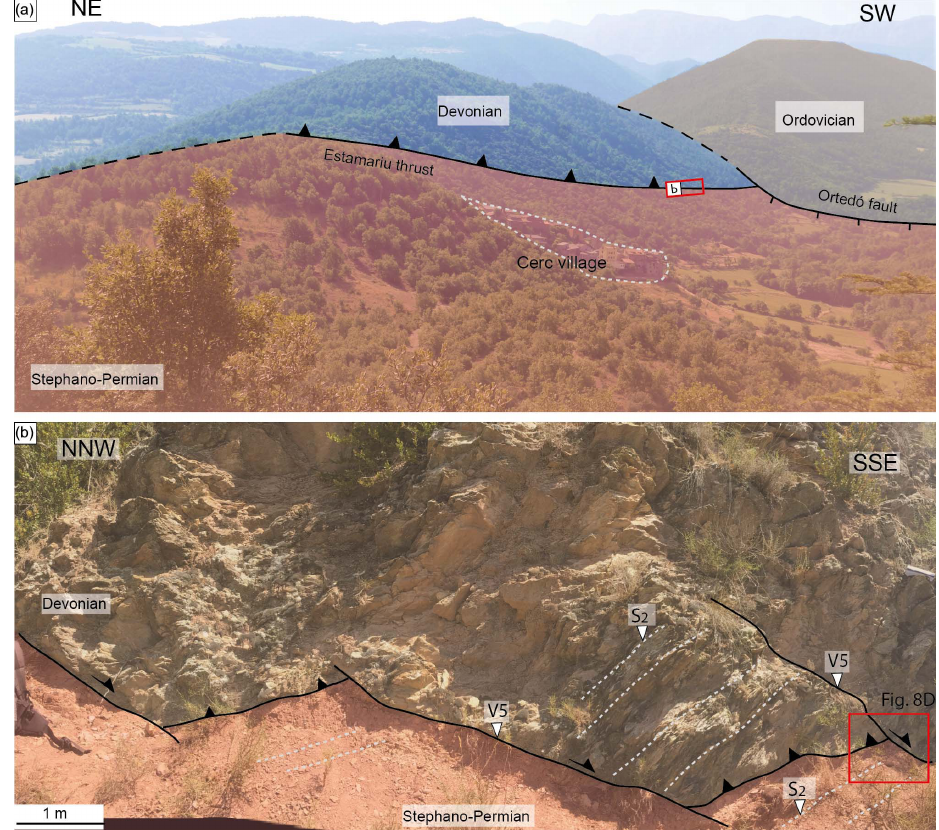
Figure 4. Main outcrop of the Estamariu thrust. (a) Panoramic view from the Sant Antoni hill showing the extensional Ortedó fault postdating the Estamariu thrust. (b) Main outcrop showing the Estamariu thrust and the related thrust zone foliation developed in the Devonian hanging wall and in the Stephano-Permian footwall (S 2 ). The thrust is displaced by later shear fractures locally mineralized with calcite